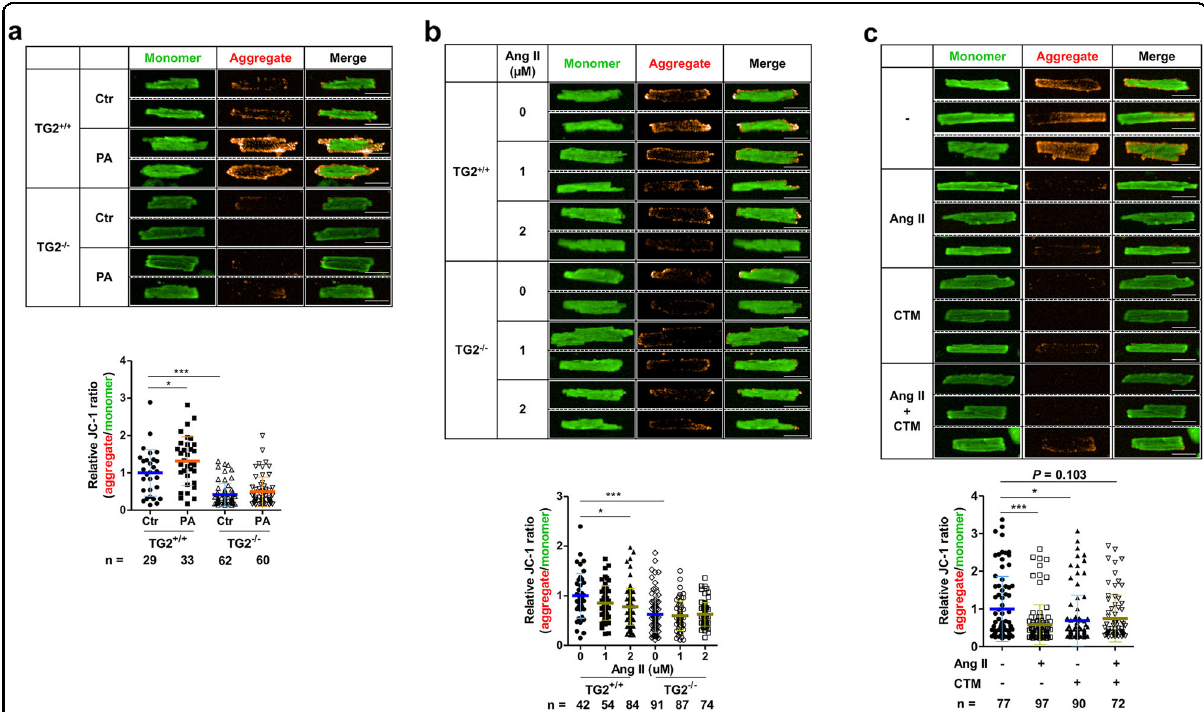
Fig. 4 TG2 is required for palmitic acid-induced hyperpolarization of mitochondrial membrane in LV myocytes. a , b LV myocytes from wild- type and TG2-de fi cient mice were treated with PA ( a , 100 µM) and Ang II ( b , 1 or 2 µM). c Rat LV myocytes were treated with Ang II (1 µM) and/or CTM (0.5 mM). Cells were stained with JC-1 dye. Representative images are shown (upper) and the JC-1 ratio is analyzed (lower). Data represent mean ± S.D. * P < 0.05, *** P < 0.001 compared with control. Scale bar, 50